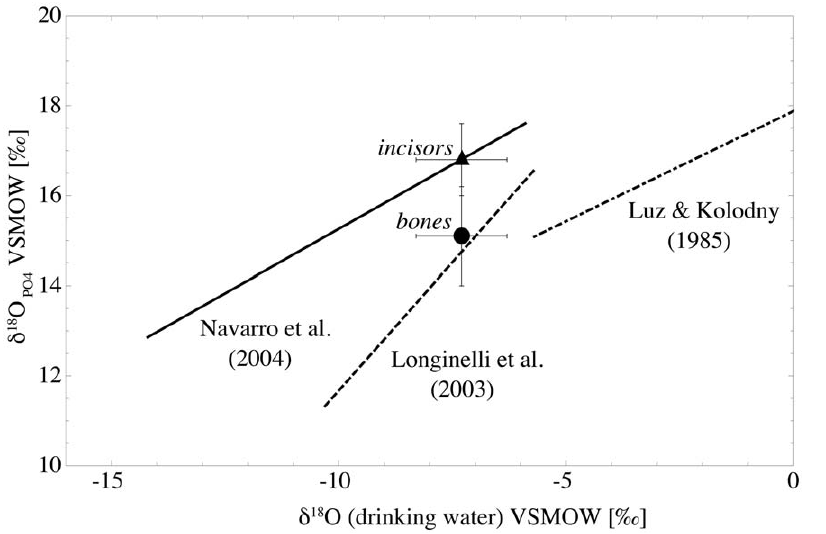
Figure 9. Tooth (triangle) and bone (circle) mean values of all analysed samples converted from d 18 O CO3 to d 18 O PO4 and plotted versus the long term d 18 O average of local precipitation (-7.3 % ). Dashed lines show the existing d 18 O PO4 - d 18 O LW regression lines for rodents developed mainly on bone material by Luz & Kolodny (1985) and Longinelli et al. (2003) [4,36]. The solid line shows the d 18 O PO4 - d 18 O LW calibration equation from Navarro et al. (2004) [16], which is mainly based on tooth material.